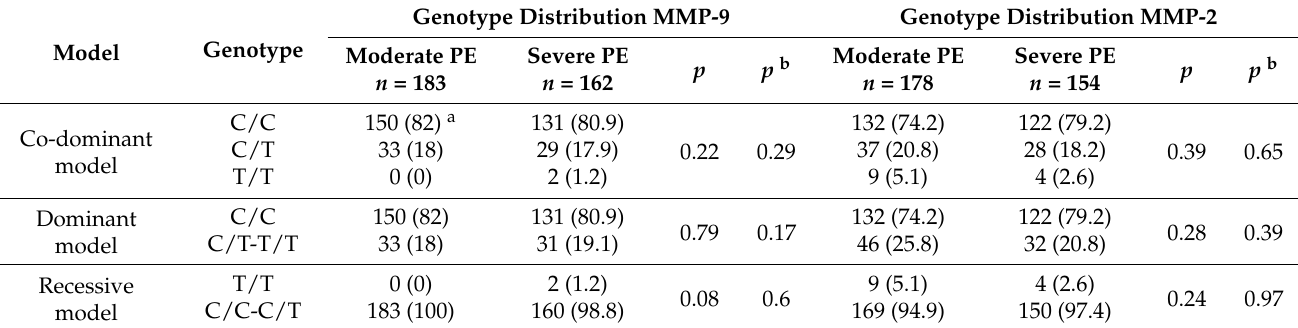
Table 4. Association of MMP-9 and MMP-2 genotypes with the severity of